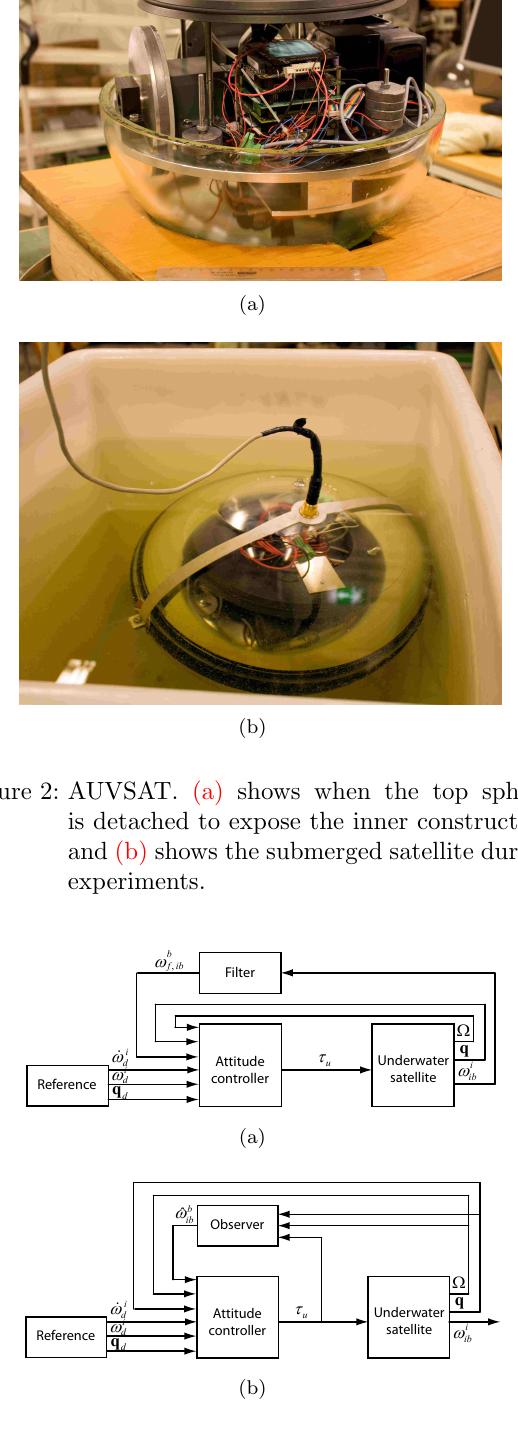
Figure 3: Block diagram of system where (a) filters the angular velocity measurement, whereas (b) estimates the angular